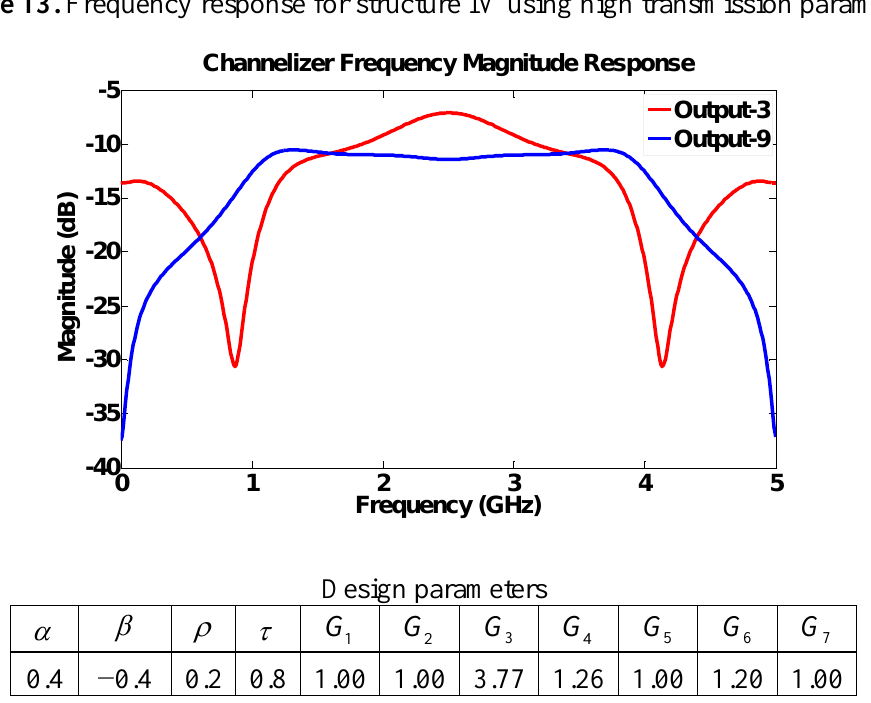
Figure 13. Frequency response for structure IV using high transmission